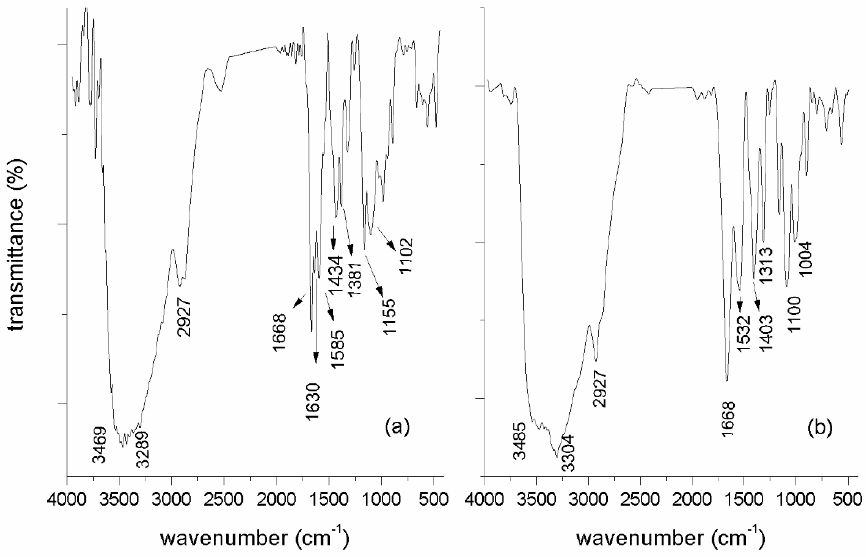
Figure 1. FTIR spectrum in KBr of ( a ) CS- g -BIB, and ( b ) CT- g -PA.